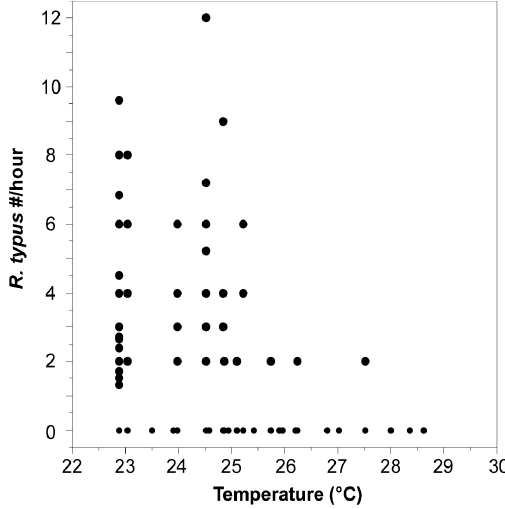
Fig. 3. Relationship between SST and sighting frequency of R. typus . Least square regression’s result between SSTand whale shark sightings per diver hour 2 1 in the vicinity of Darwin’s Arch from November 2007 to December